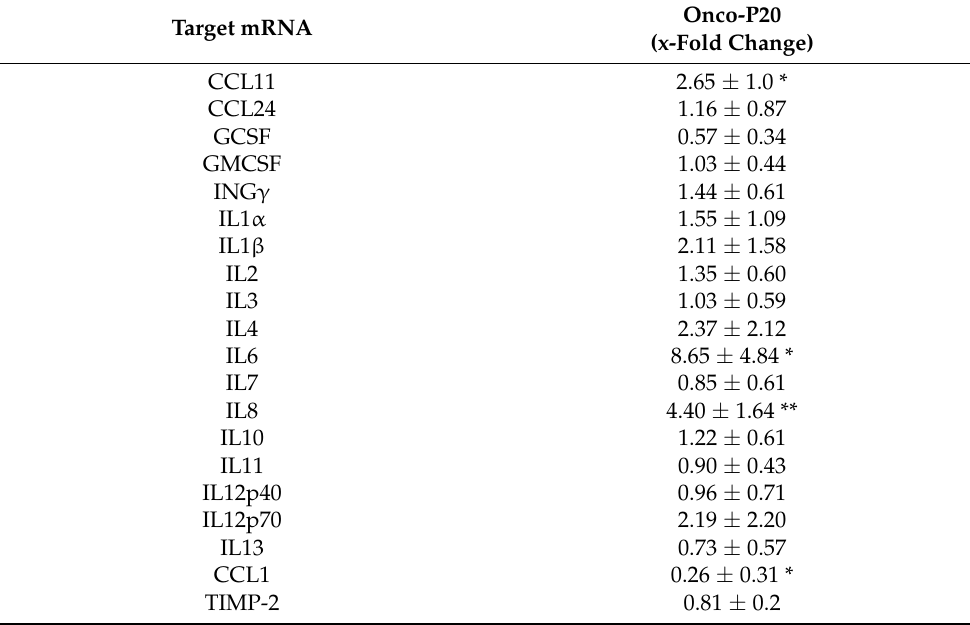
Table 3. Semi-quantitative analysis of multiple cytokines secreted by Onco-P20-treated fibroblasts after 2 weeks of continuous treatment. Data represent x-fold increase or decrease with respect to untreated cells. Results are the mean ± SD of four different experiments performed with fibroblasts isolated from independent donors. * p < 0.05 and ** p <